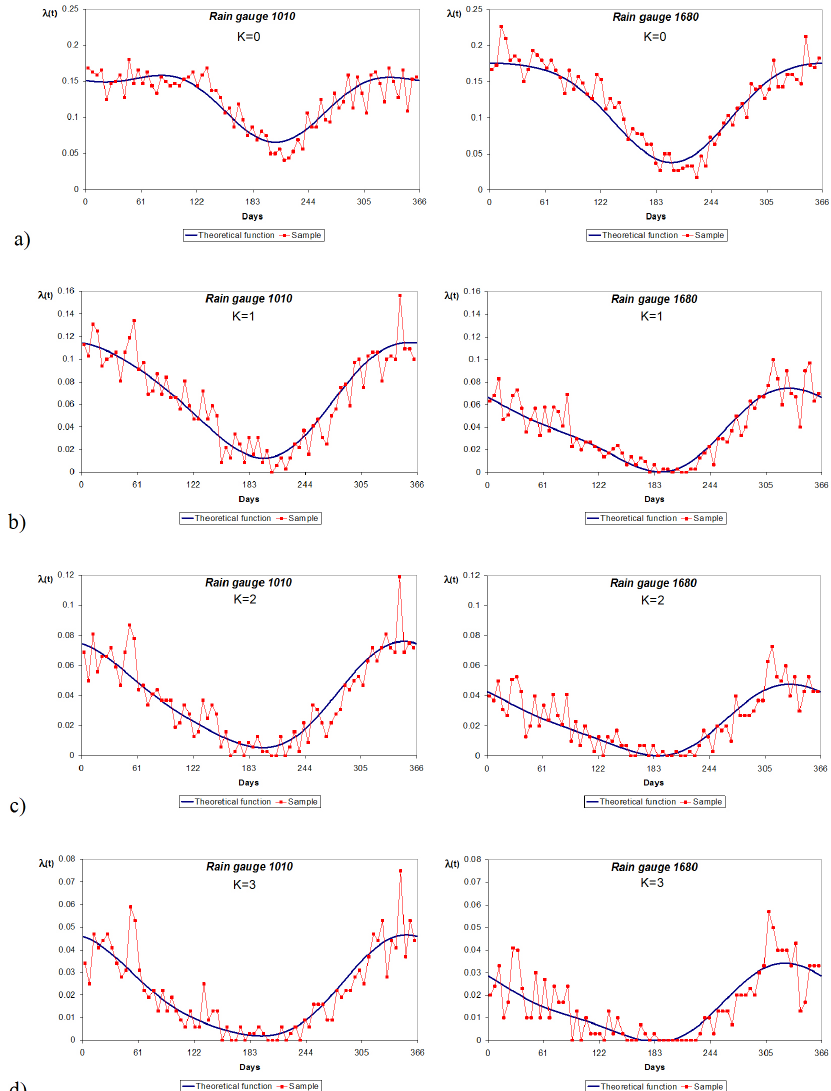
Fig. 7. Cosenza (1010) and Crotone (1680) rain gauge: sampling vs. theoretical distribution of intensity function λ(t) by using Fourier series with 2 harmonics, for K = 0 (a) , K = 1 (b) , K = 2 (c) and K = 3 (d)